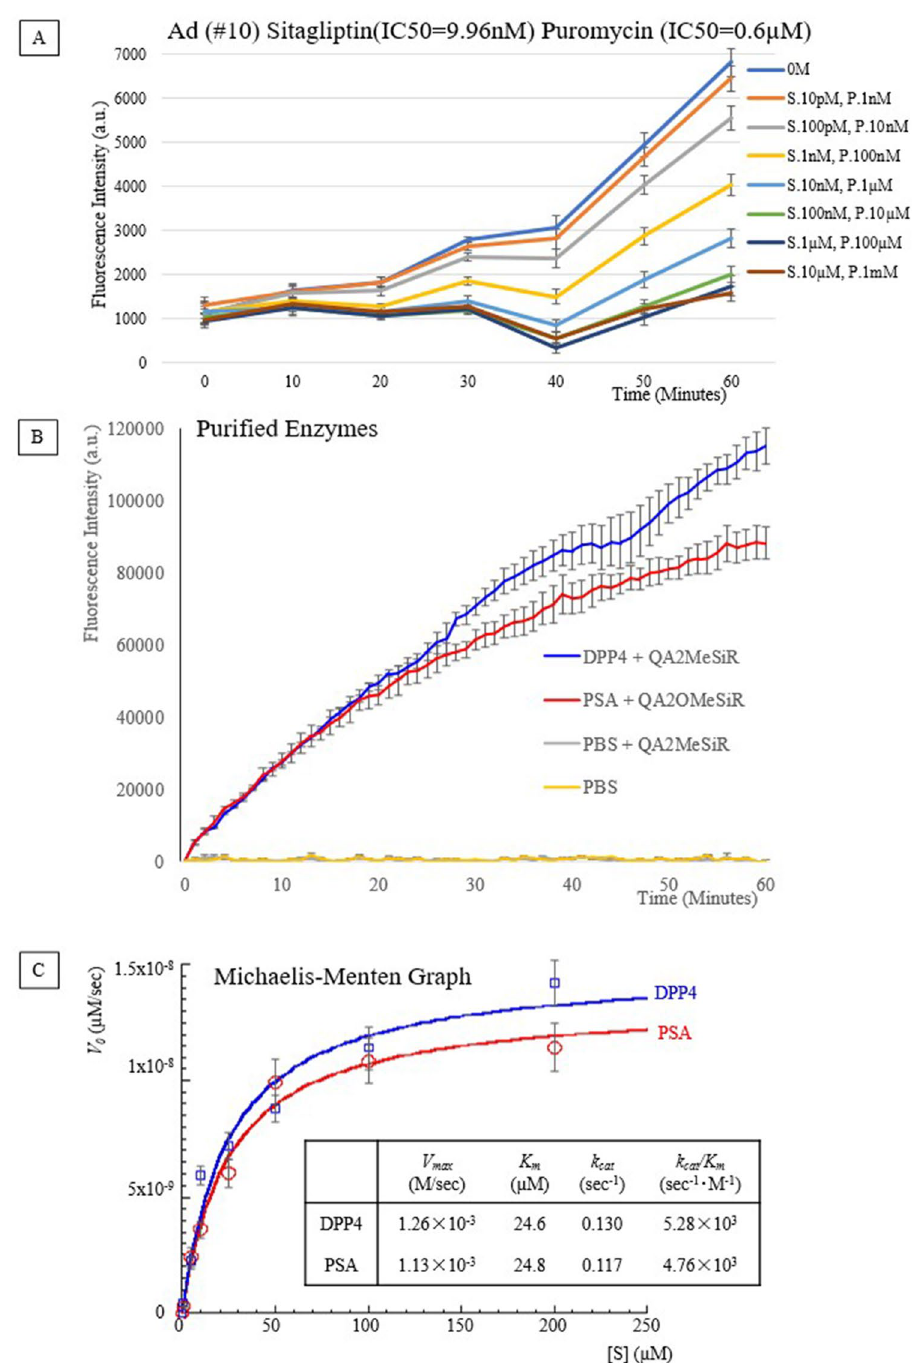
Figure 5. (A ) Fluorescence of adenocarcinoma lysate and QA-2OMeSiR in the presence of various concentrations of sitagliptin and puromycin in combination. Puromycin at concentrations above 1 µM (above the IC 50 ) suppressed the increase in fluorescence. When both sitagliptin and puromycin were used at concentrations around the IC50 values ("sitagliptin 10 nM, puromycin 1 µM"; light blue line) and above, the inhibitory effect was increased. Error bars indicate standard errors. Triplicate measurements were conducted using the same lysate and inhibitors. S sitagliptin, P puromycin. ( B) Assay of purified enzymes and QA-2OMeSiR. The fluorescence intensity of purified DPP4 and PSA (0.114 µM) mixed with QA-2OMeSiR increases with time. ( C) Plot of the initial velocities of the enzymatic reaction with DPP4 and PSA against concentration of QA-2OMeSiR, and the kinetic parameters obtained using the Michaelis–Menten equation, V 0 = V max × [S]/( K m + [S]). The catalyst efficiency, kcat/Km , was about 1.1 times higher for DPP4 than for PSA. Error bars indicate standard errors. Triplicate measurements were conducted using enzymes with the same lot